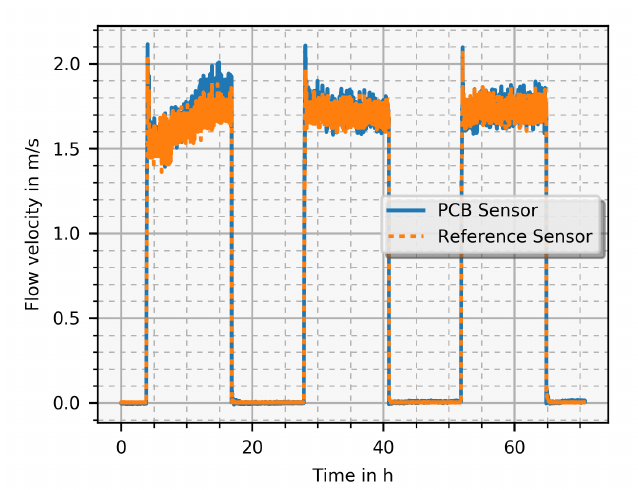
Figure 10. Long-term measurement where the sensor was tested in a normal operation mode of the HVAC system that was controlled by an automatic system. PCB and reference sensor were measured every 10s during three days. The scaling factor for the PCB sensor is given in Equation(2).